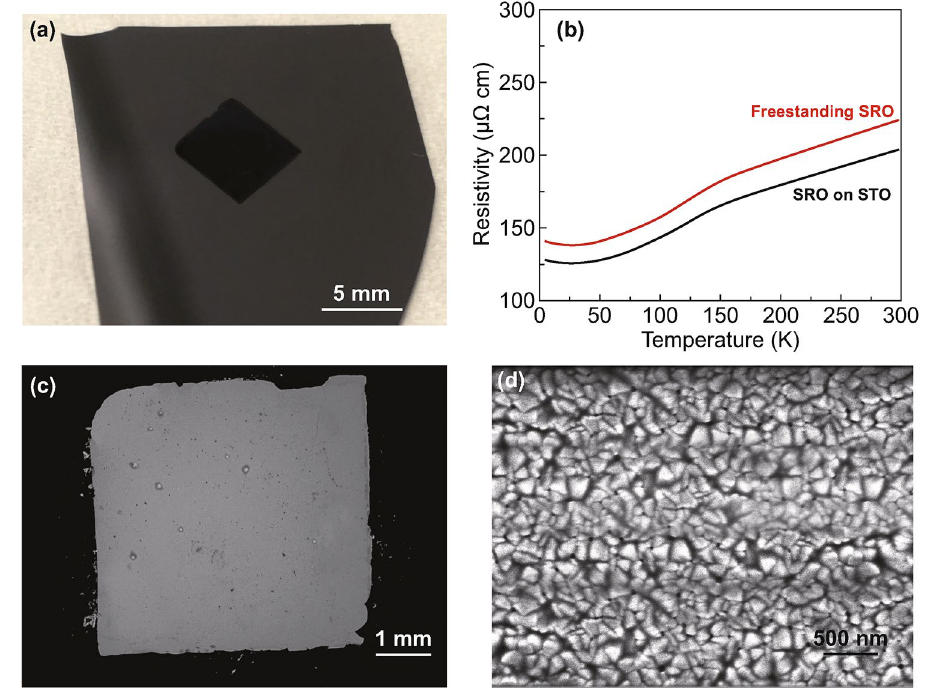
Fig.4 a Optical image of the surface of a SrRuO 3 film (5 × 5 mm 2 ) transferred by the optimized method IV of Figs. 1 and 2. b Resistivity meas‑ urements for the SrRuO